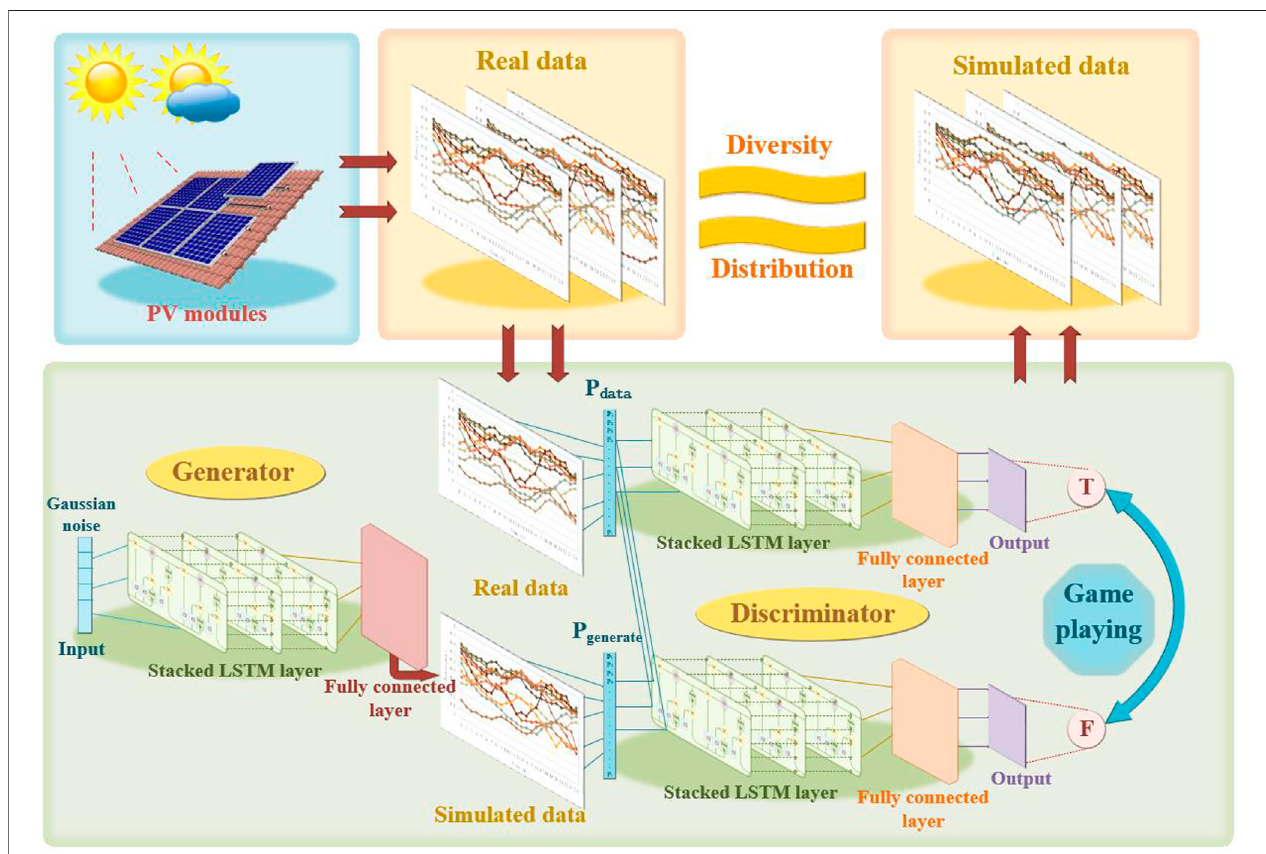
FIGURE 1 | Photovoltaic power generation uncertainty simulation method based on